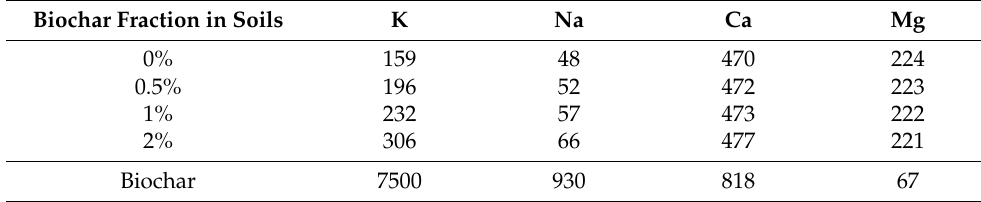
Table 2. Concentration of the exchangeable cations (in mg kg − 1 ) of the biochar/soil mixtures.